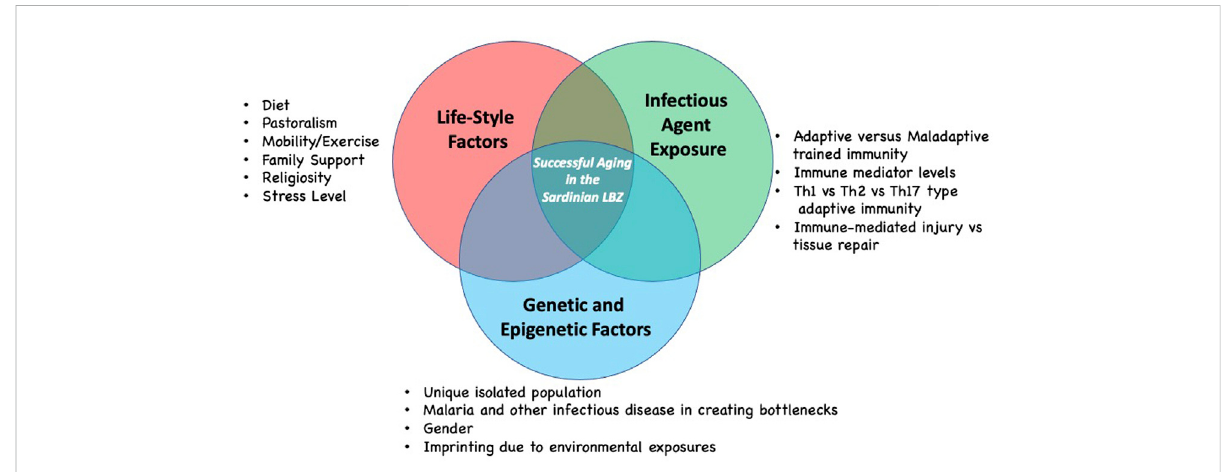
FIGURE 2 HypothesesregardingthecomplexityoffactorsthatmaycontributetolongevityasseenintheSardinianLBZ.Eachfactorgroupmaycontribute indifferingwaystosuccessfulagingbasedonlivedexperienceofindividuals.FuturecontributorstosuccessfullongevityintheSardinianLBZmaystill be identi fi